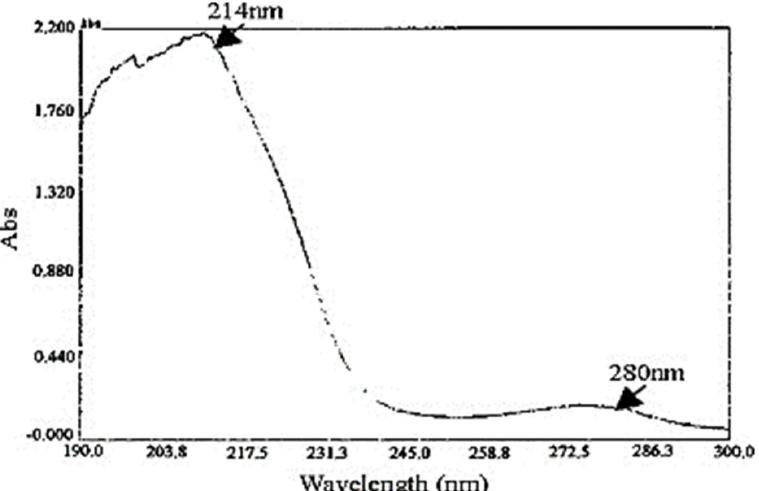
Figure 4. UV–Vis spectra of sericin. Reproduced with permission from Wu et al. [39], 2007, Elsevier (originally Figure 1).